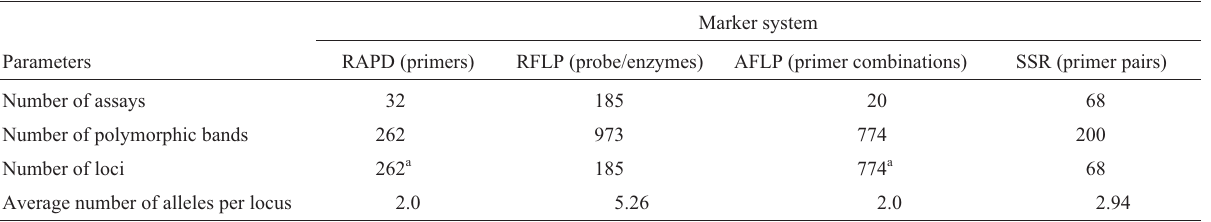
Table 2 - Levels of polymorphism in 18 maize inbred lines evaluated using random amplified polymorphic DNA (RAPD), restriction fragment length polymorphism (RFLP), amplified fragment length polymorphism (AFLP) and simple sequence repeat (SSR) markers.